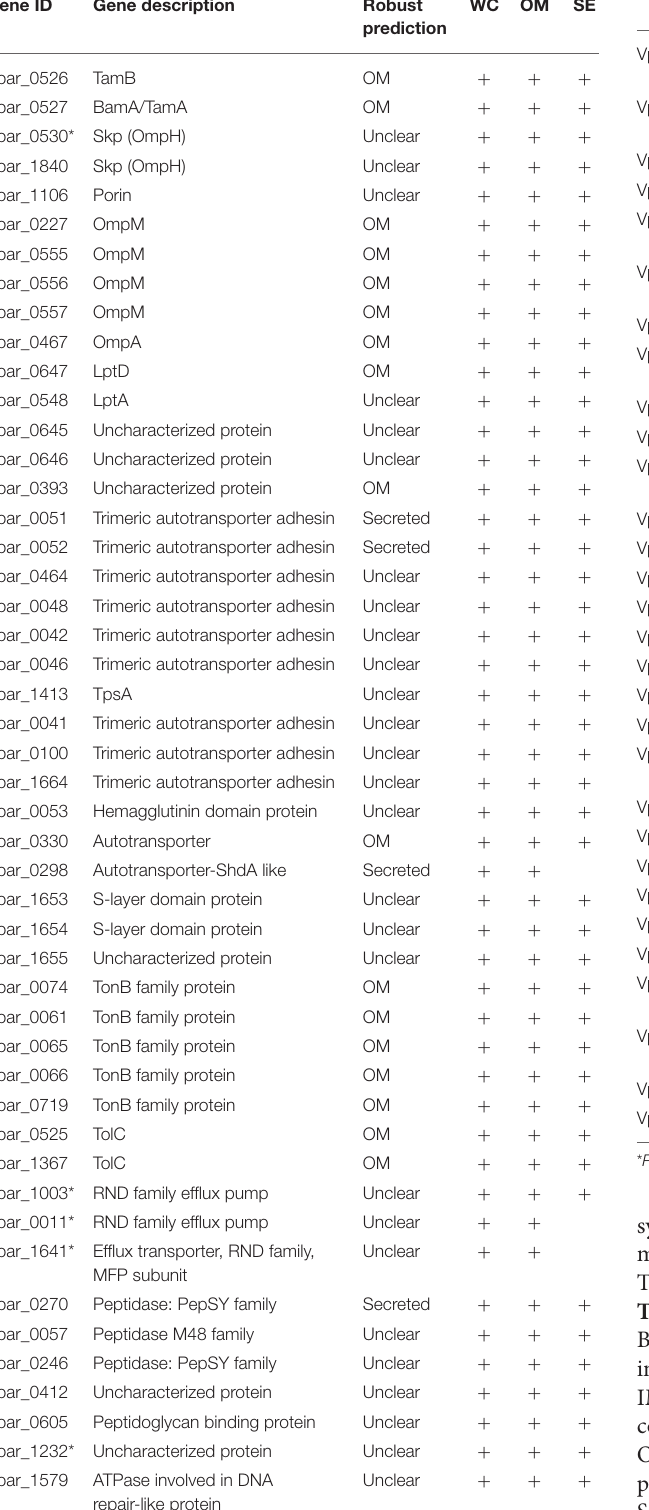
TABLE 1 | 78 OM proteins identified by bioinformatic localization and proteomic analysis. Order follows discussion in text. Gene ID Gene